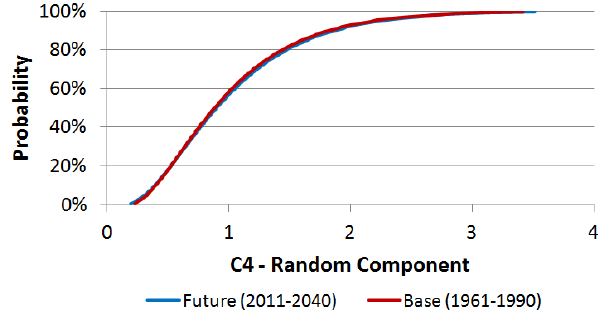
Figure 14. Adjustment of the Gamma distribution for the modeling of the random component in a low flow situation, C3( t ) less than 1, for the base and future